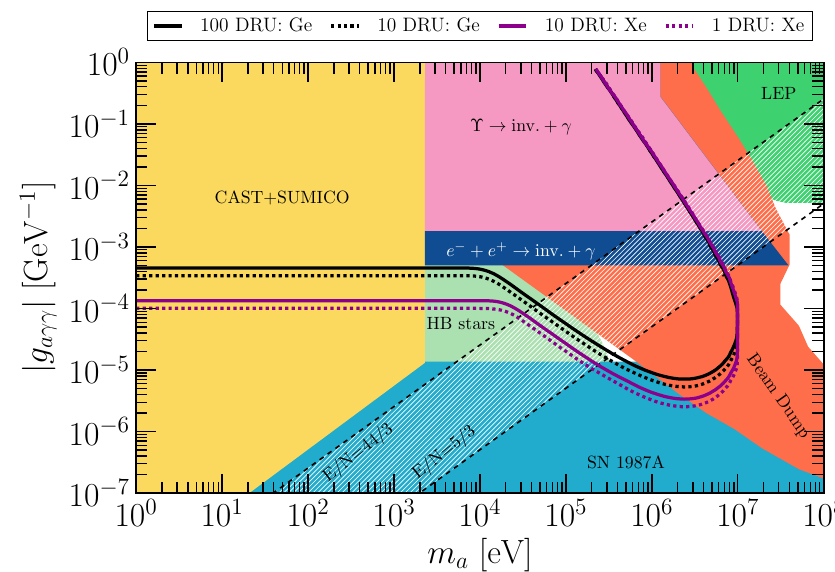
Figure 10 . Photon-ALP coupling 90% CL sensitivities along with relevant laboratory, astrophysical and cosmological limits that apply in the region of interest, adapted from refs. [103, 108, 109]. Black contours correspond to 90% CL sensitivities achievable with ongoing or near-future experiments (see table 3). Purple contours instead indicate 90% CL sensitivites that could be achieved in a next generation experiment. Solid (dotted) contours refer to sensitivities under the assumption of a background rate of 100 DRU (10 DRU) for ongoing or near-future experiments, while to 10 DRU (1 DRU) for a next generation setup. See the text for more details. For completeness we show